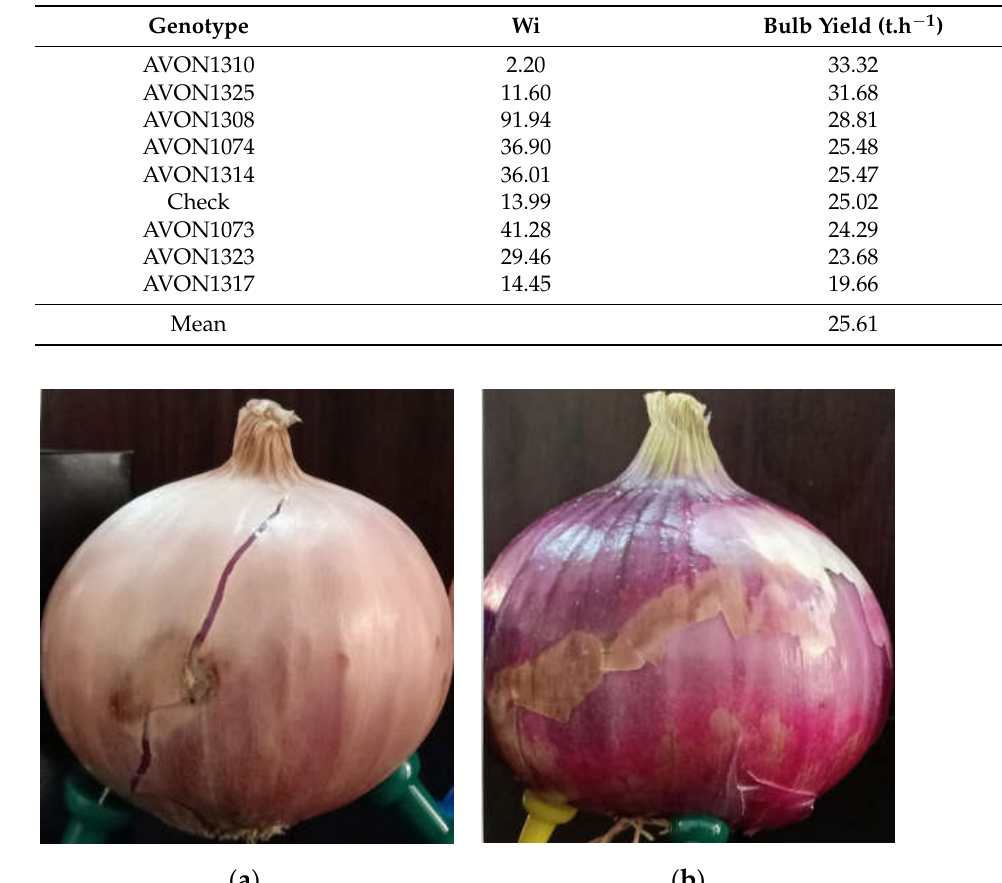
Figure 3. Photos of two high-performing and stable onion varieties. ( a ) Light-red-colored bulb of variety AVON1308; ( b ) red-colored bulb of variety AVON1310. Photo credit: World Vegetable Center.